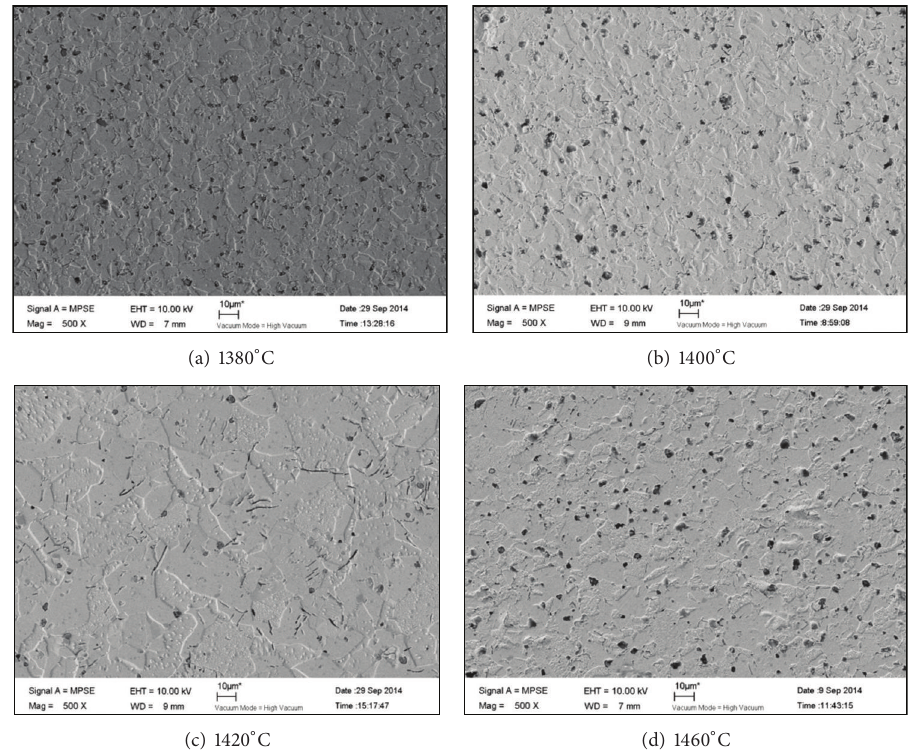
Figure 4: SEM micrographs of AZO targets sintered at (a) 1380 ∘ C, (b) 1400 ∘ C, (c) 1420 ∘ C, and (d) 1460 ∘ C.